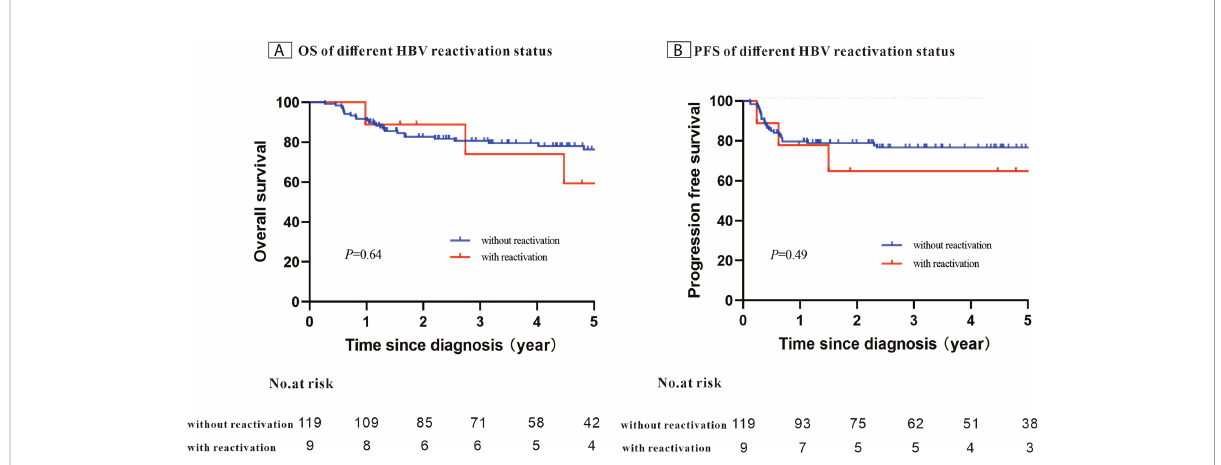
FIGURE 3 Kaplan – Meier survival curves for patients with Hepatitis B surface antigen (HBsAg)-positive diffuse large B-cell lymphoma (DLBCL) strati fi ed using the patients ’ Hepatitis B virus (HBV) reactivation status (N =